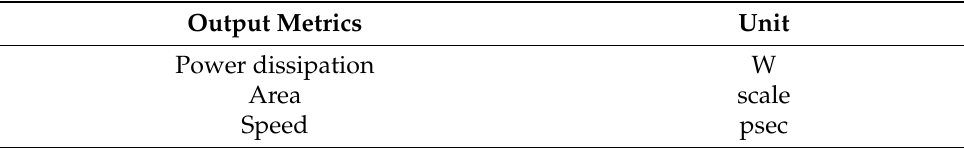
Figure 7. Schematic of SAR ADC timing controller consisting of variable delay cells. Table 7. Performance output metrics of the asynchronous clock control module.